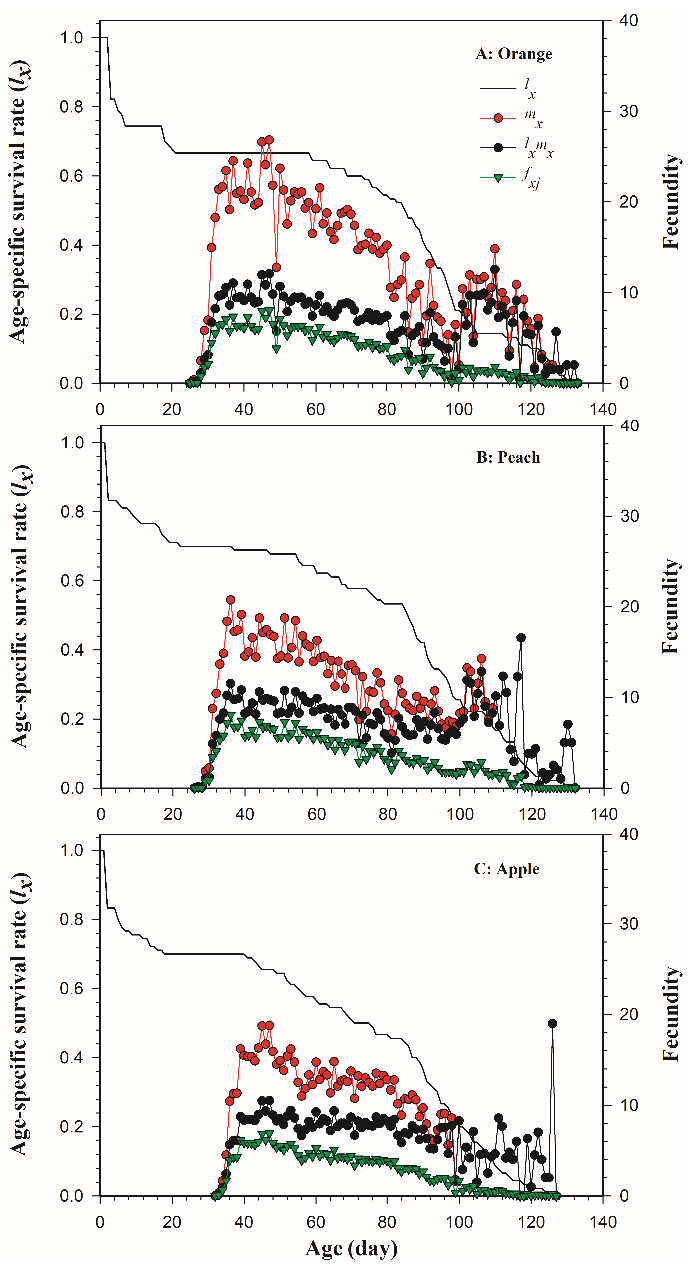
Figure 2. The age-specific survival rate ( l x ), the age-stage specific fecundity ( f xj ), the age-specific fecundity ( m x ), and age-specific maternity ( l x m x ) of Bactrocera dorsalis on three host fruits: ( A ) orange; ( B ) peach; ( C ) apple.